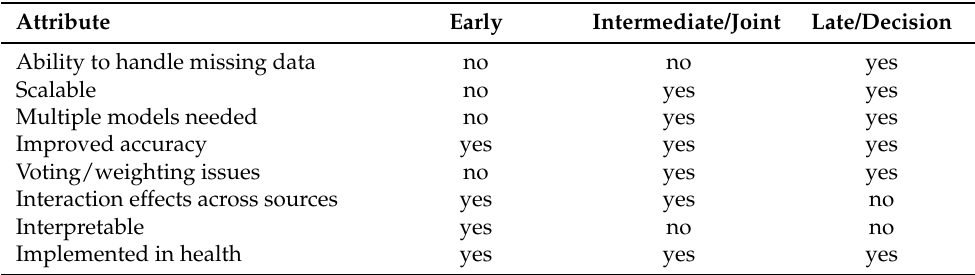
Table 2. Data fusion approach